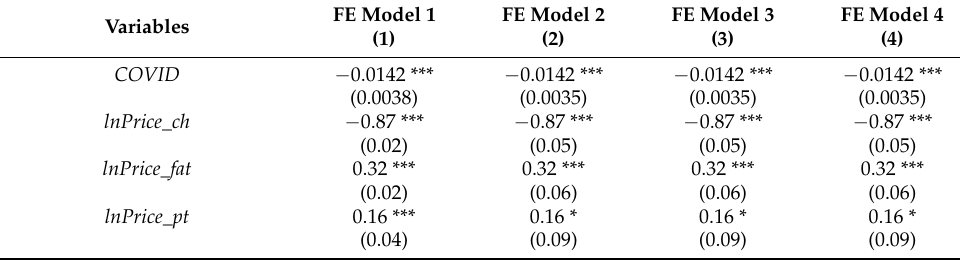
Table 4. Estimation results of the COVID-19 impact on carbohydrate